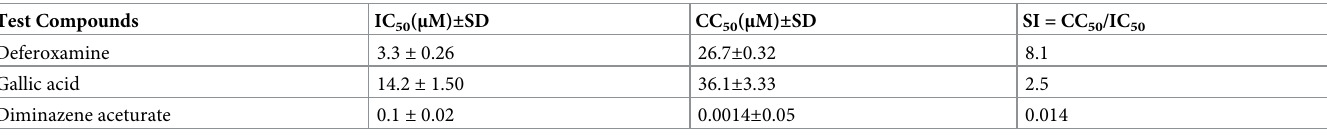
Table 3. Selectivity index (SI) of test compounds against macrophage cell lines. Test